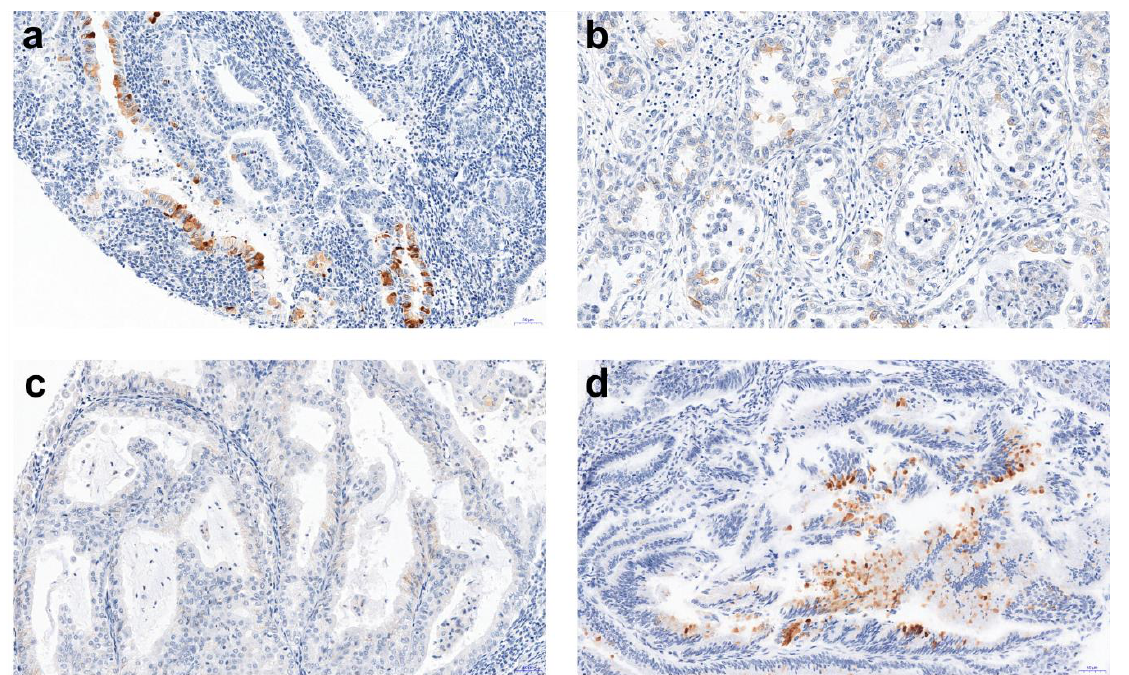
Figure 1. A representative example (20 × magnification) of the immunohistochemistry (IHC) reaction: ( a ) well-differentiated (G1) endometrioid carcinoma showing focal but intense positive, membranous staining with AMH; ( b ) clear cell carcinoma showing few scattered anti-Müllerian hormone (AMH) positive cells with low intensity of staining. ( c ) AMH negative staining of well-differentiated (G1) endometrioid carcinoma; ( d ) well differentiated (G1) endometrioid carcinoma showing few scattered AMH positive cells with moderate intensity of staining.